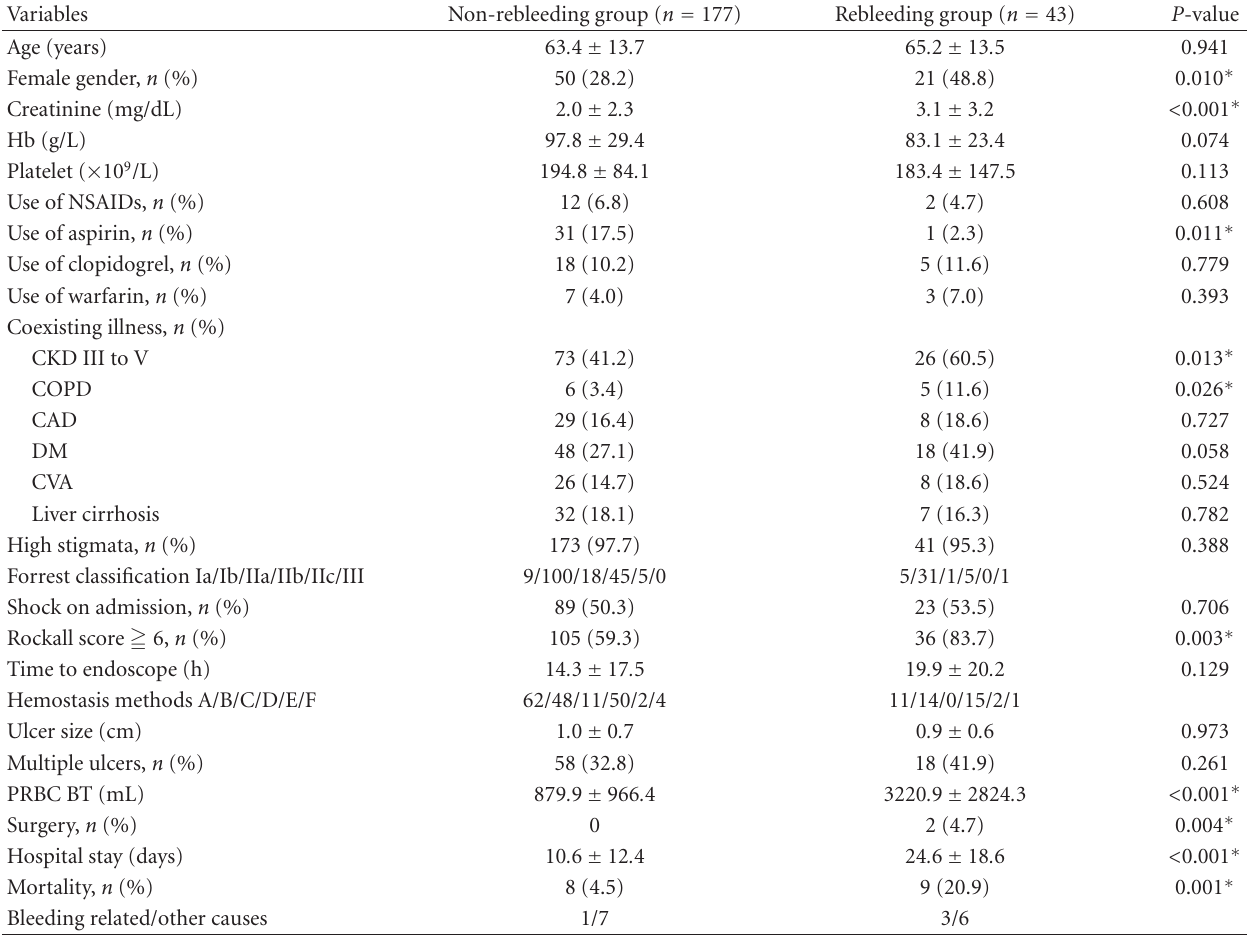
Table 1: Univariate analysis of demographic and clinical characteristics of non-rebleeding and rebleeding patients.